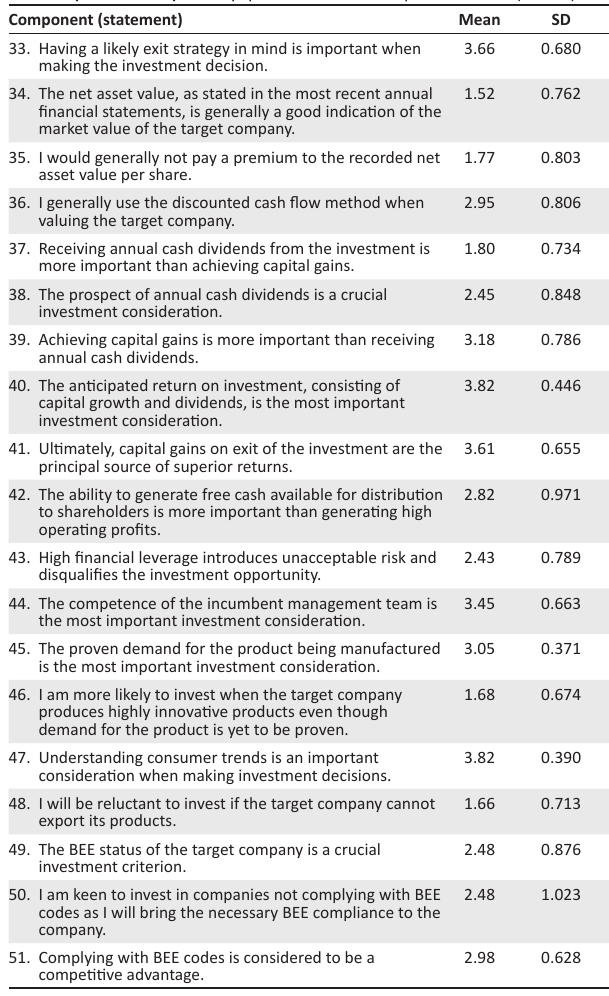
TABLE 1: Survey questionnaire: Descriptive statistics ( N = 44). TABLE 1 (Continues...): Survey questionnaire: Descriptive statistics ( N =